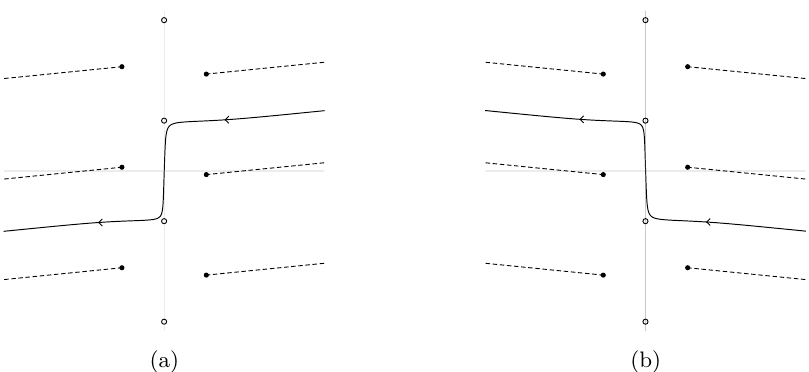
Figure 11. Transmitted saddles ( Re( η ) < w ) . When η is real and less than w , the only transmitted saddles are singular. Non-singular solutions are found for complex η . On the left η has a small positive phase and on the right it has a small negative